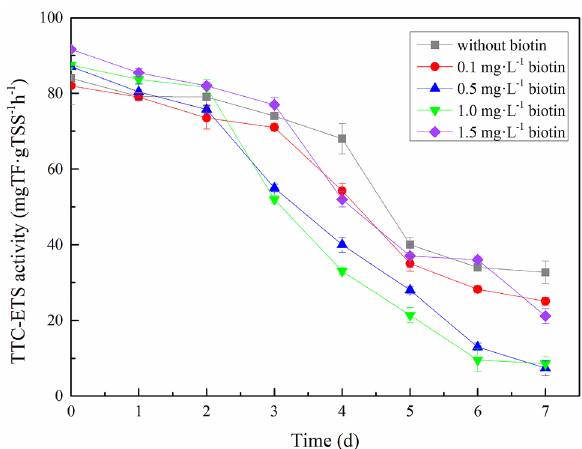
Figure 4. TTC-ETS activity under various biotin